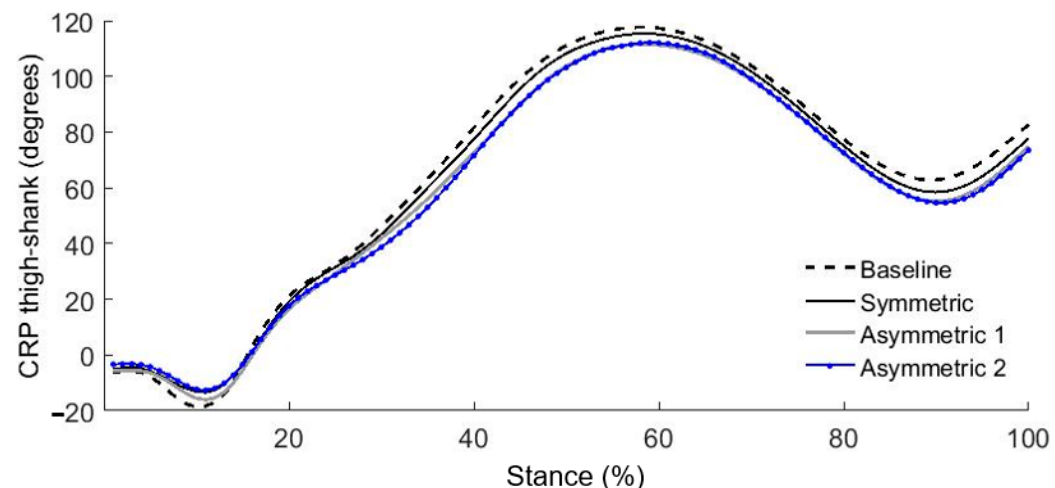
Figure 3. Mean continuous relative phase (CRP) curves in thigh-shank on the loaded side during stance phase for baseline (no load) and each experimental condition ( n = 25).